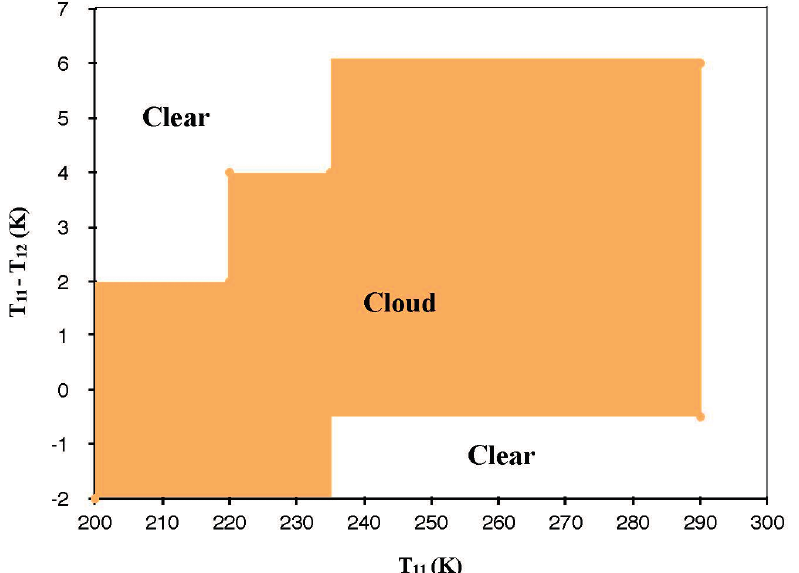
Figure 2. Two-dimensional and threshold-based (2D-THR) cloud detection algorithm using brightness temperature difference ( T 11 − T 12 ) and the brightness temperature at 11-µm channel ( T 11